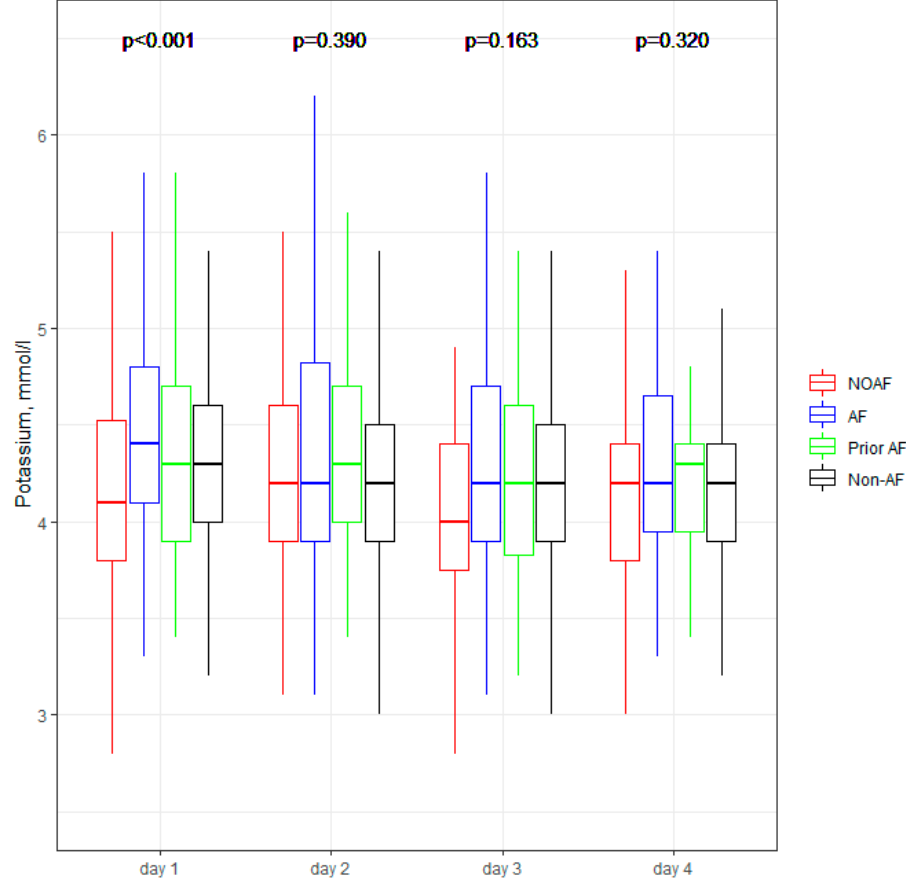
Figure 4. Potassium concentration within the first four days of hospitalization. The center repre- sents the median value. The upper and lower quartiles values are displayed with whiskers. p -values on the figure represent the group changes (the Kruskal–Wallis test). The time changes were calcu- lated by the Friedman test and paired samples Wilcoxon test with Bonferroni adjusted ( p < 0.004). NOAF—group of patients with any newly diagnosed AF that appeared during AMI hospitalization; AF—group of patients with a previously documented diagnosis of AF who additionally had AF during AMI hospitalization; Prior AF—group of patients with a previously documented diagnosis of AF who had not developed AF during AMI hospitalization; Non-AF—group of patients with no evidence of AF during AMI hospitalization and without the prior AF diagnosis.